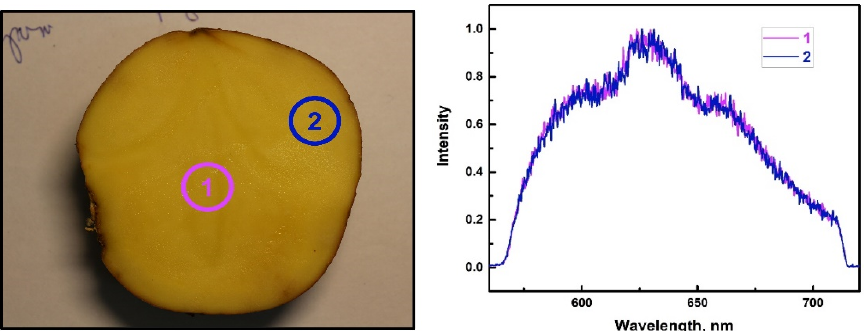
Figure 11. Example of sampling points ( left ) and fluorescence spectra ( right ) of the central part (pink) and the main volume (blue) of the potato tuber of the Zhukovsky variety. It turned out that the spectra were almost identical for this sample. As the sorted ‐ out potato tubers had various types of lesions, we recorded the fluorescence spectra for each type of defect (Figure 12).